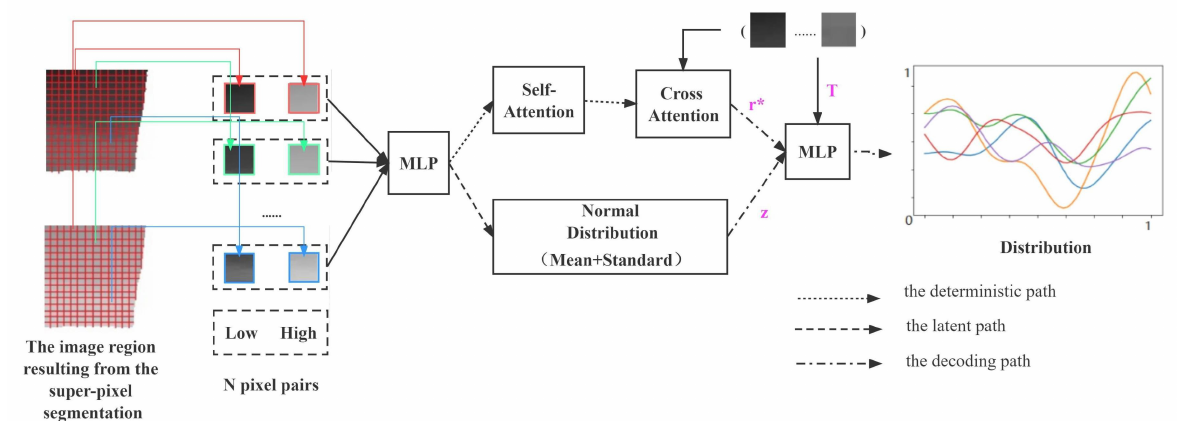
Figure 5. The structure of the